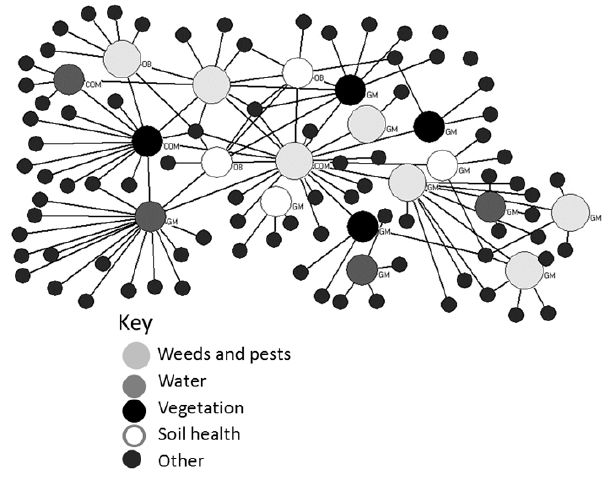
Fig. 2 . High priority natural resource management issues for Landcare Group B respondents.